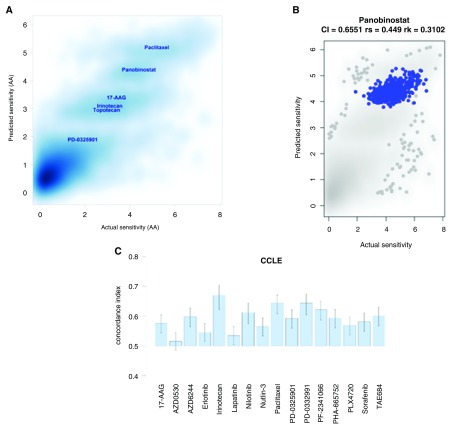
Different views of our model’s predictive capacity on the CCLE dataset using alternative performance indicators.(
A) Density plot of predicted vs. actual sensitivity values (n=10981). Pearson, Spearman and Kendall correlation coefficients: 0.86, 0.73 and 0.54, respectively. (
B) Focused view of the predicted vs. actual sensitivity for panobinostat, one of the drugs displaying the highest (actual and predicted) activity area (AA) values. Additional examples in Supplementary Figure S5. (
C) Concordance indices between the predicted and the observed AA values for a selected set of drugs. An index value = 0.5 is the expected value from random prediction. Error bars: 95% confidence interval of the estimated concordance index.